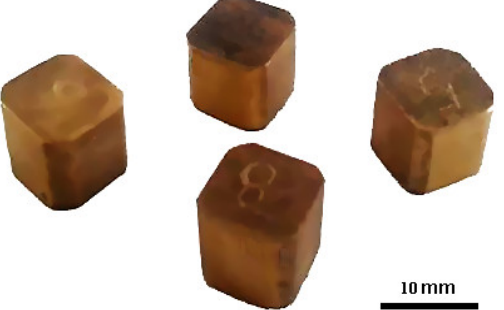
Figure 1. Sample shape after